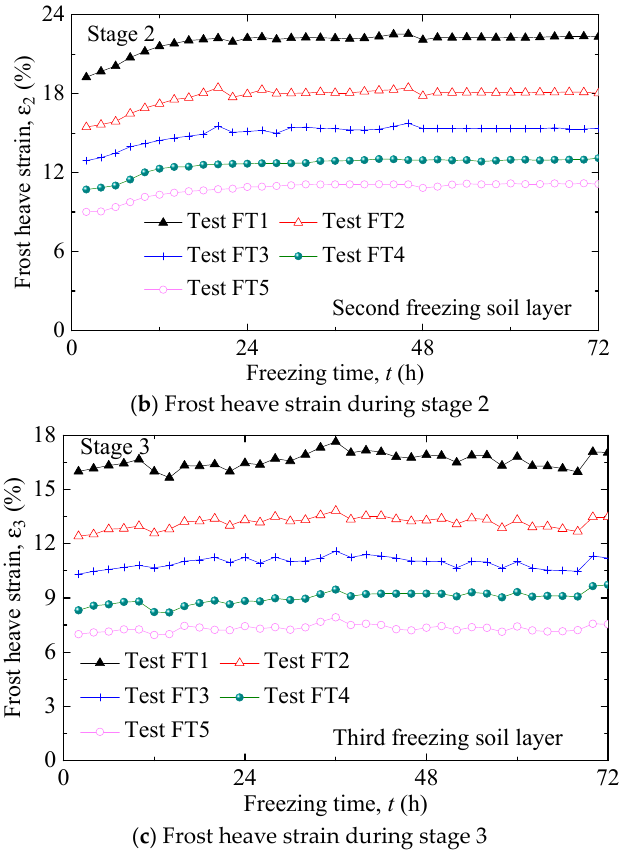
Figure 11. Frost heave strain in freezing soil layers during ( a ) stage 1, ( b ) stage 2, and ( c ) stage 3.